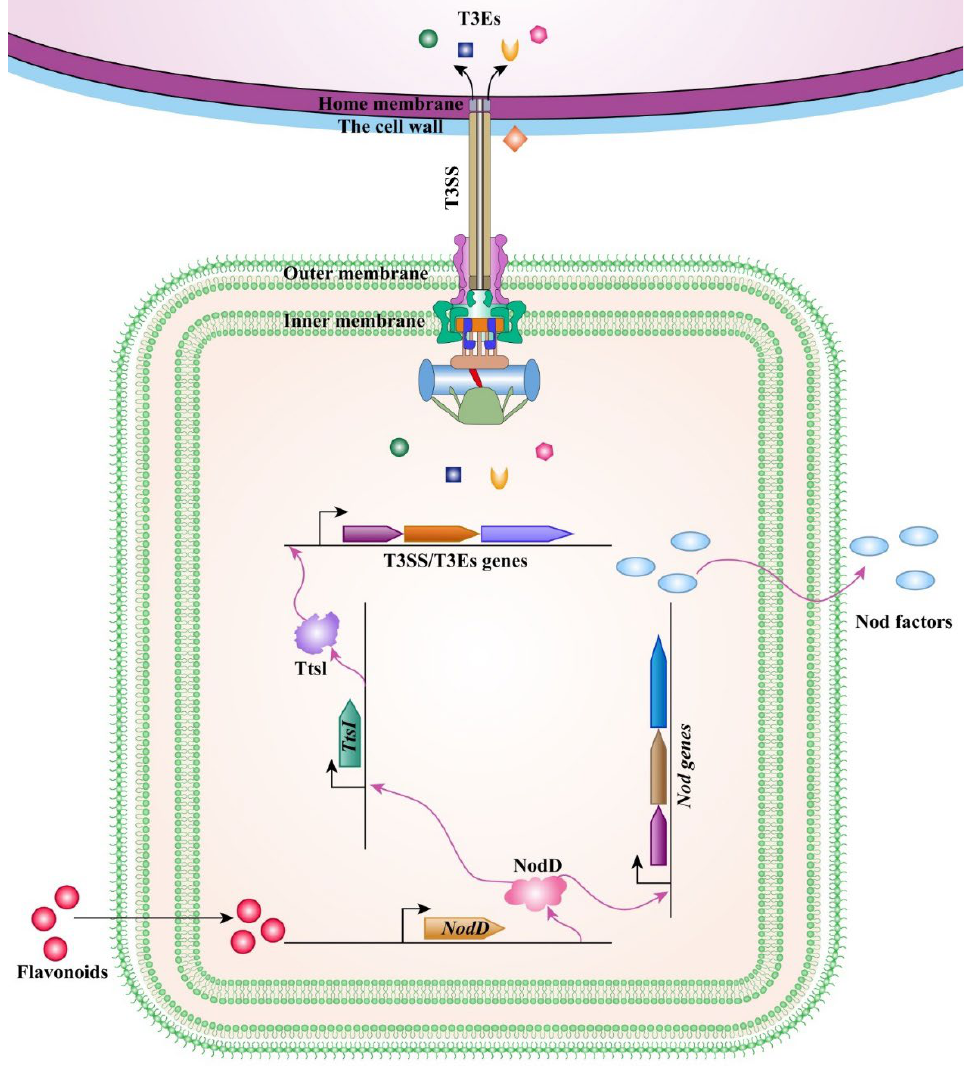
Figure 4. The regulation and expression of type III effectors. Flavonoids released by legume roots trigger the expression of NodD . NodD induces the synthesis of Nod factors and the expression of TtsI . TtsI then binds to the tts box element of the promoter of T3SS/T3Es genes to regulate the synthesis of T3SS/T3Es. Table 1. Core structural components and functions of T3SSs and T3Es in rhizobia.